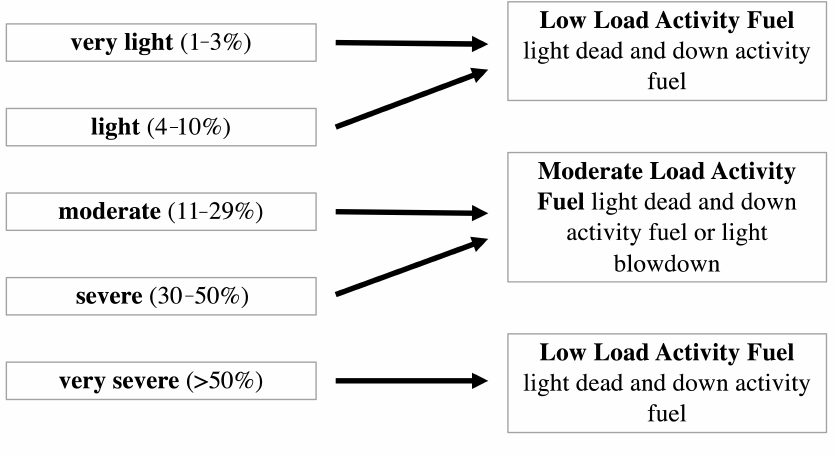
Figure 1. Insect and Disease Detection Survey (IDS) tree mortality classes mapped to Scott and Burgan 40 fuel models from the slash-blowdown class. Polygons from the IDS were mapped to their most representative fuel